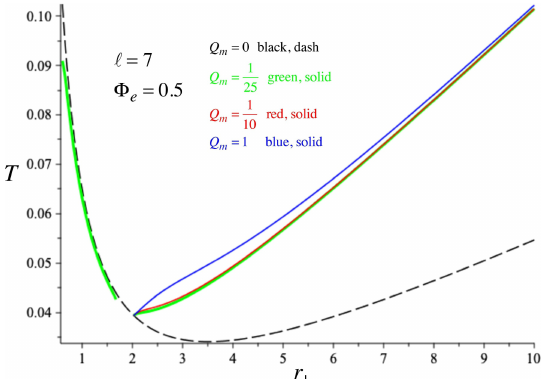
Figure 13 . Temperature vs. Horizon size for nonzero magnetic charge at fixed electric potential. This plot of T vs. r + at ψ ( I ) = 0 exhibits a discontinuity in temperature for various values of Q m N relative to the Q m = 0 case. For sufficiently large Q m black hole solutions do not exist at small r + . Here ‘ = 7 and Φ e = 0 . 5 .